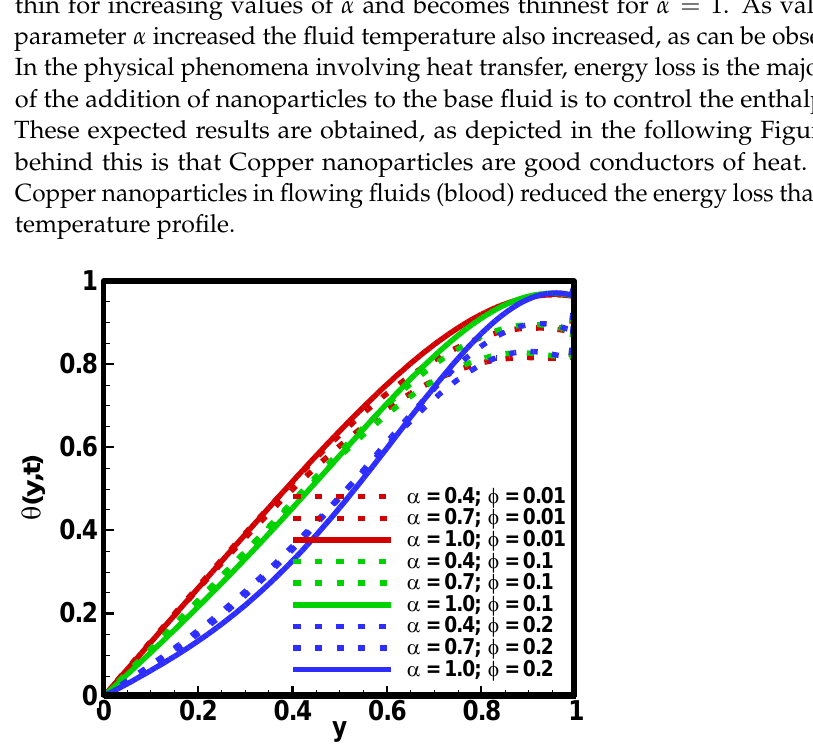
Figure 9. Influence of 𝜙 on 𝜃(𝑦, 𝑡) when 𝐺𝑟 = 5, 𝐻𝑎 = 5, 𝜆 2𝛽 = 0.1, 𝑃𝑟 =21, and 𝜙 = 0.1 .